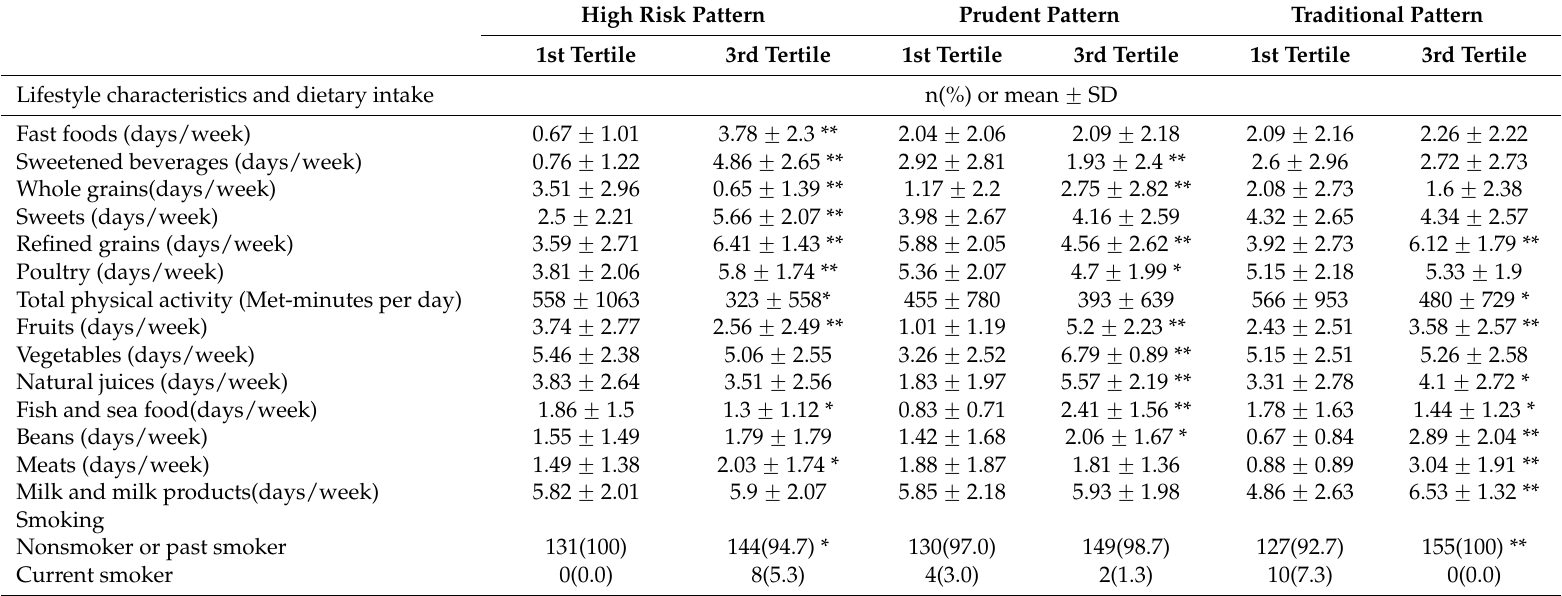
Current smoker 0(0.0) Significance was derived from ANOVA test for continuous variables and chi square test for categorical